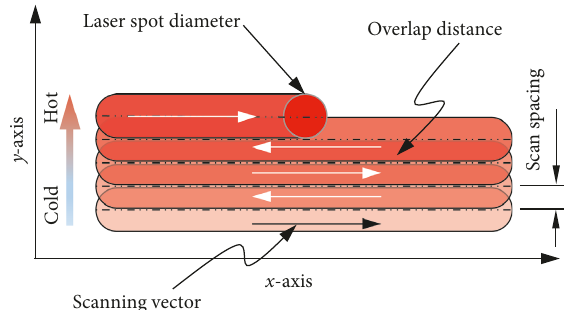
Figure 2: Scanning pattern of “DTM Sinterstation 2000”